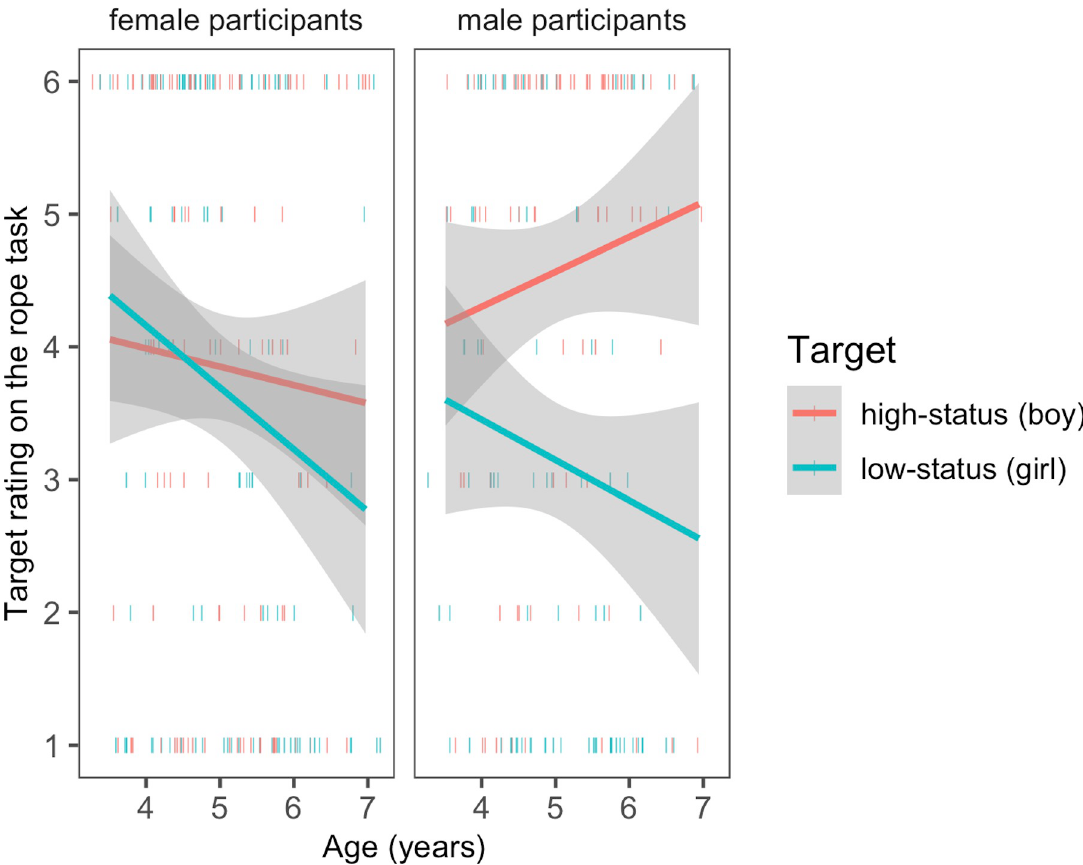
Fig 2. Responses on the rope task as a function of participant gender and age. Shaded areas show 95% confidence bands around the regression lines; dashes represent individual participants.